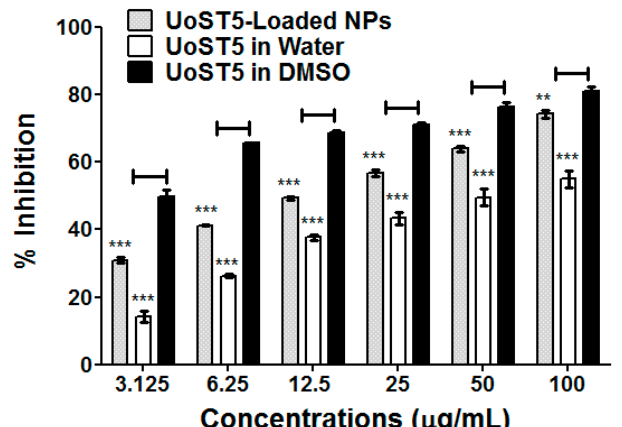
Figure 4. Anti- Candida activity of UoST5-Loaded NPs compared to free synthesized compound. The anti- Candida auris activity of UoST5-NPs in water was compared to UoST5 in water and DMSO at di ff erent concentrations (3.125, 6.25, 12.5, 25, 50 and 100 µ g / mL). C. auris at 10 4 CFU / mL was grown in 96 well microplate containing YPD broth. The plates were incubated at 37 ◦ C for 24 h prior to measurement at 600 nm using a plate reader. Cultures without compounds were employed as negative control. The data display the mean of the percentage of the survival rate of mammalian cells ± standard error of the mean. A P -value < 0.05 was considered as significant. The level of significance was indicated by asterisks (** P < 0.01: *** P < 0.001)